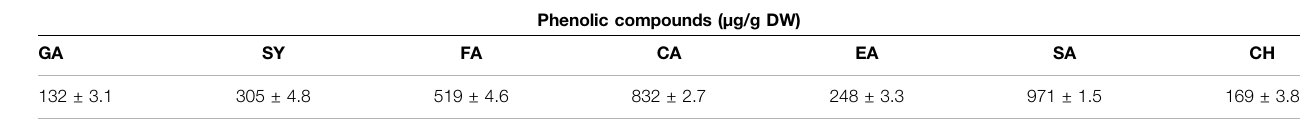
TABLE 3 | Phenolic compounds presented in Achillea millefolium phenolics-loaded nanoliposomes. Phenolic compounds (µg/g DW)